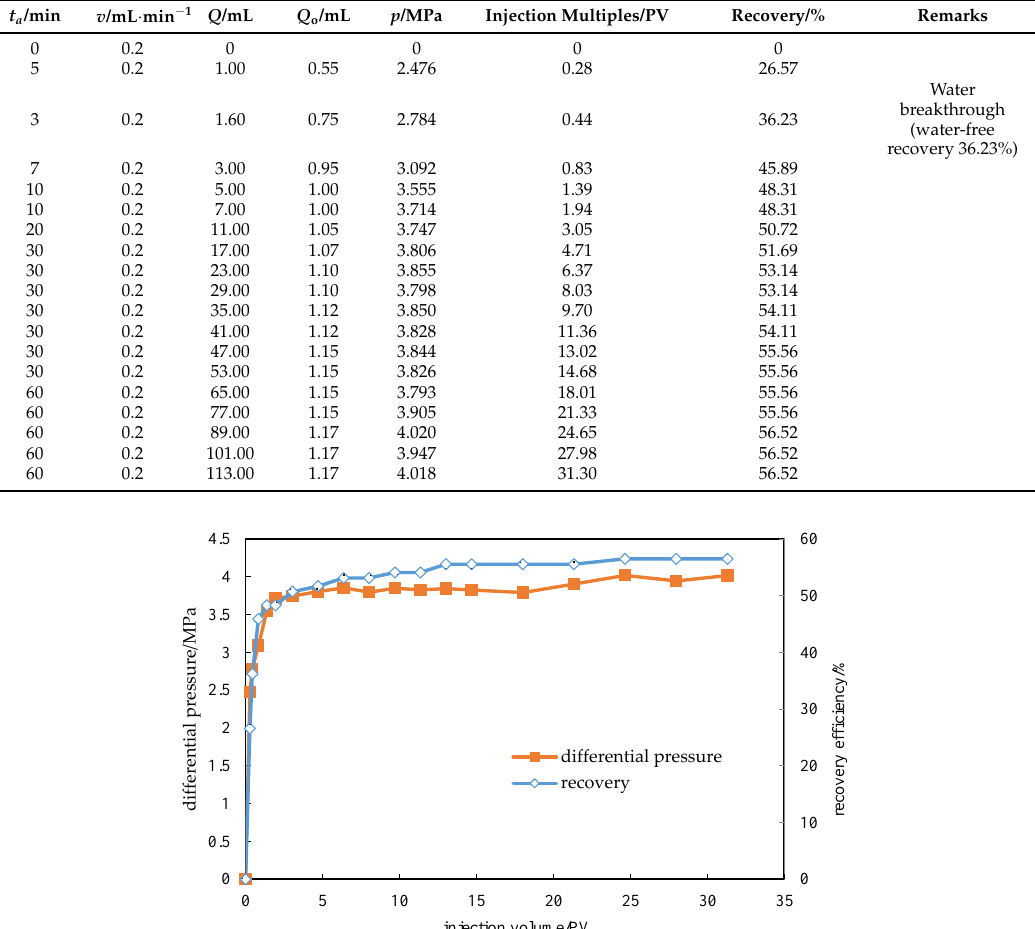
Table 6. Water flooding experimental results.